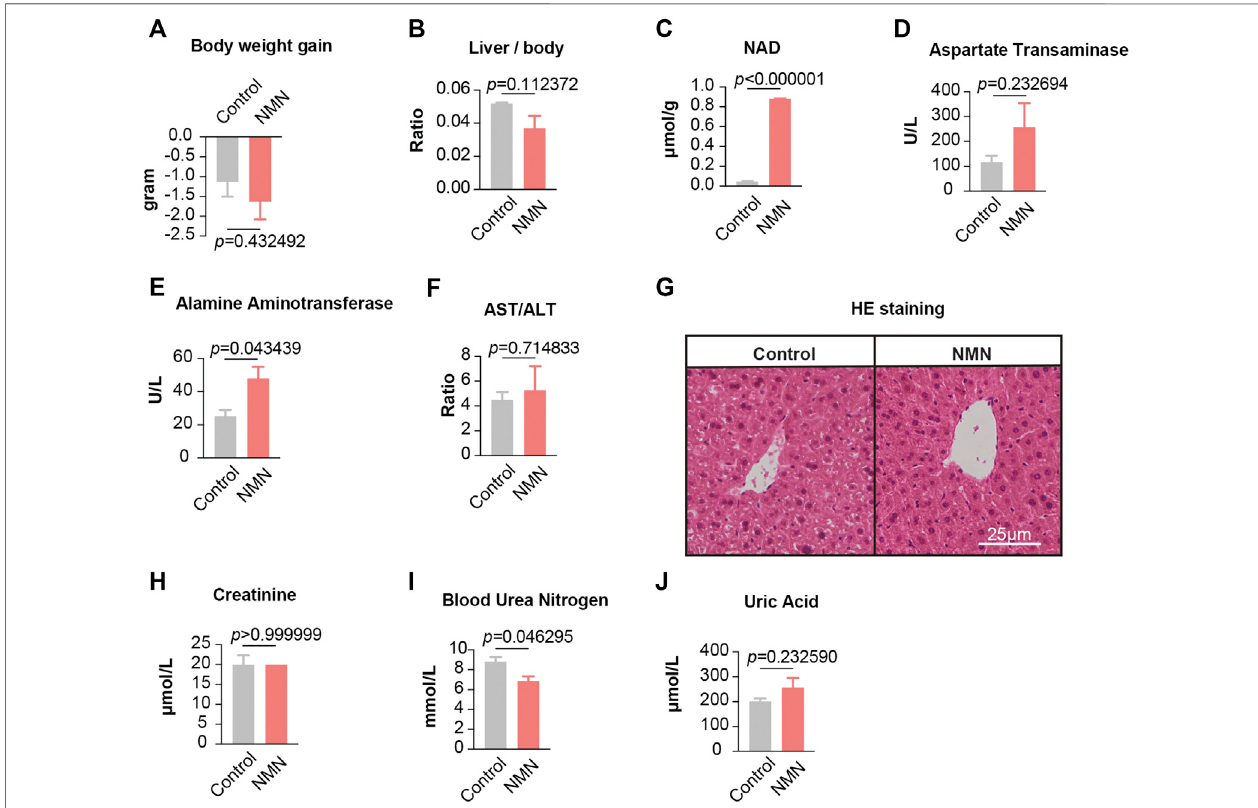
FIGURE3| DataformicetreatedwithNMNtwiceperday (A) ThebodyweightsweremeasuredbeforeandafterhigherNMNadministration. (B) Theratiobetween liverweight and bodyweight wasmeasured after higher NMNadministration. (C) LiverNAD + levelswereincreasedafter higher NMNadministration. (D – F) Liverfunction were analyzed after higher NMN administration. (E) Alamine aminotransferase was evaluated in higher NMN-administered mice. (G) Photomicrograph of liver sections from higher NMN-administered mice exhibited normal hepatocytes (H&E stain). (H – J) Kidney function were analyzed after higher NMN administration. (I) Blood urea nitrogen was decreased in 1340 mg/kg/d NMN-administered